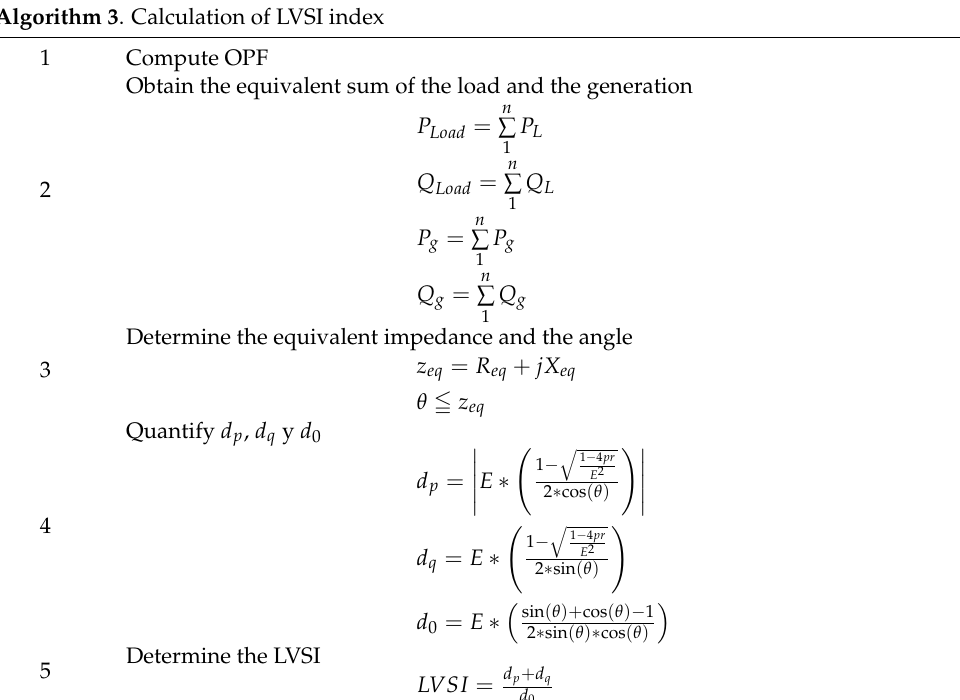
Algorithm 3 . Calculation of LVSI